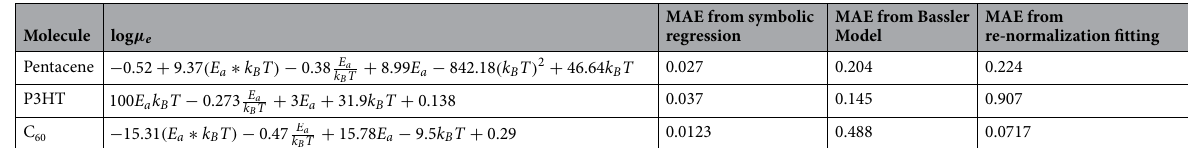
Table 1. A comparison of the MAE values obtained from the three different fitting approaches in consideration—symbolic regression (SR), Bassler model and Renormalization fitting—for pentacene, P3HT and C 60 OFETs. The second column consists of the resulting equations obtained from the SR